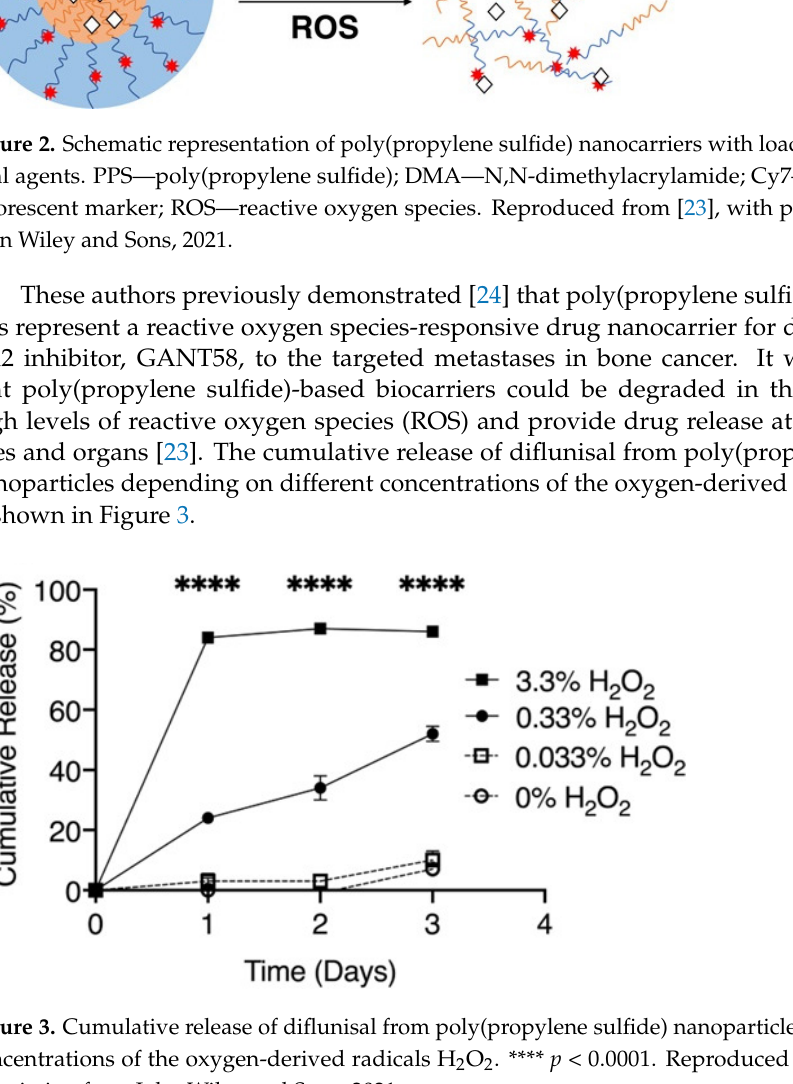
Figure 2. Schematic representation of poly(propylene sulfide) nanocarriers with loaded pharmaceu- tical agents. PPS—poly(propylene sulfide); DMA—N,N-dimethylacrylamide; Cy7—Cy7-amine, a fluorescent marker; ROS—reactive oxygen species. Reproduced from [23], with permission from John Wiley and Sons, 2021.